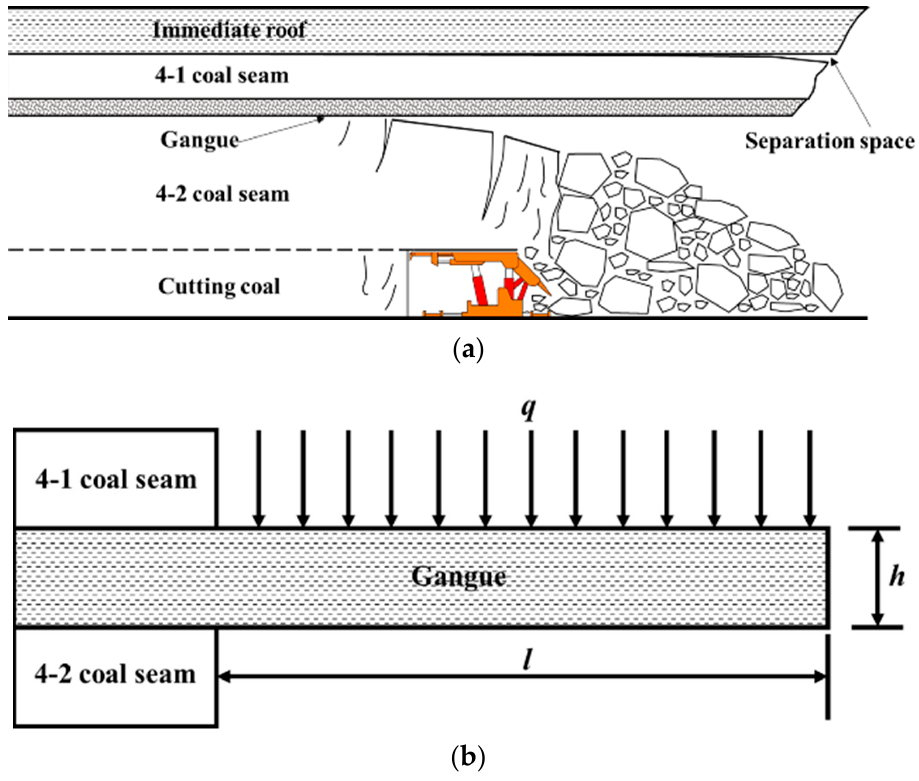
Figure 6. Force state of the high-level gangue layer. ( a ) Schematic diagram of the force state of the gangue layer. ( b ) Schematic diagram of simplified mechanical model.